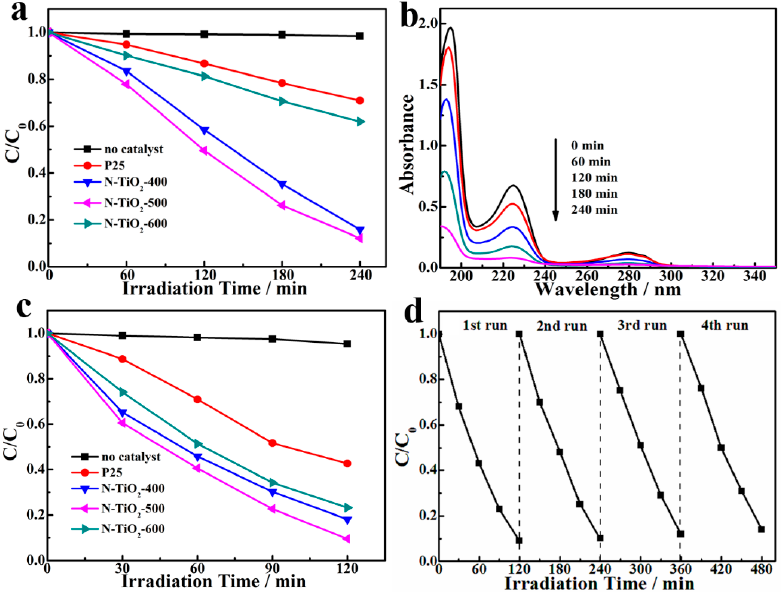
Figure 5. ( a ) Comparison of photocatalytic activities for 4-chlorophenol (4-CP) degradation ( b ) the temporal ultraviolet-visible spectral variation of 4-CP solution during photocatalytic reaction on N-TiO 2 -500 sample; ( c ) comparison of photocatalytic activities for methylene blue (MB) degradation; ( d ) stability experiments for MB degradation on N-TiO 2 -500 sample.